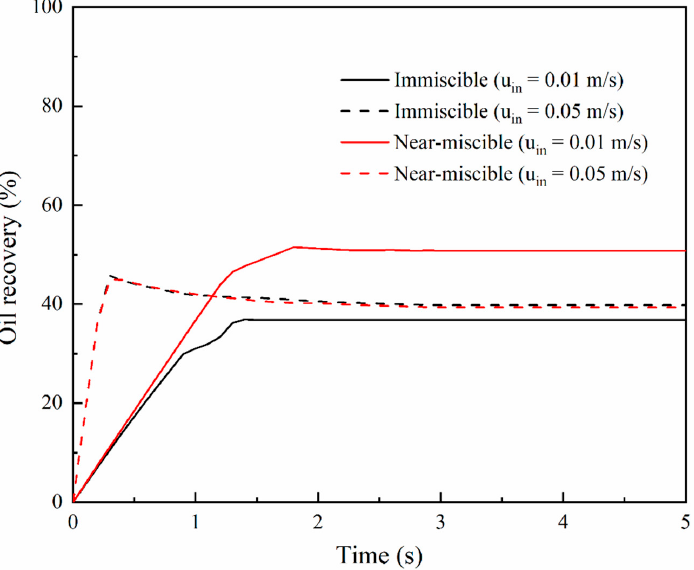
Figure 6. Oil recovery at the injection velocity of 0.01 and 0.05 m/s, respectively, under immiscible and near-miscible conditions.